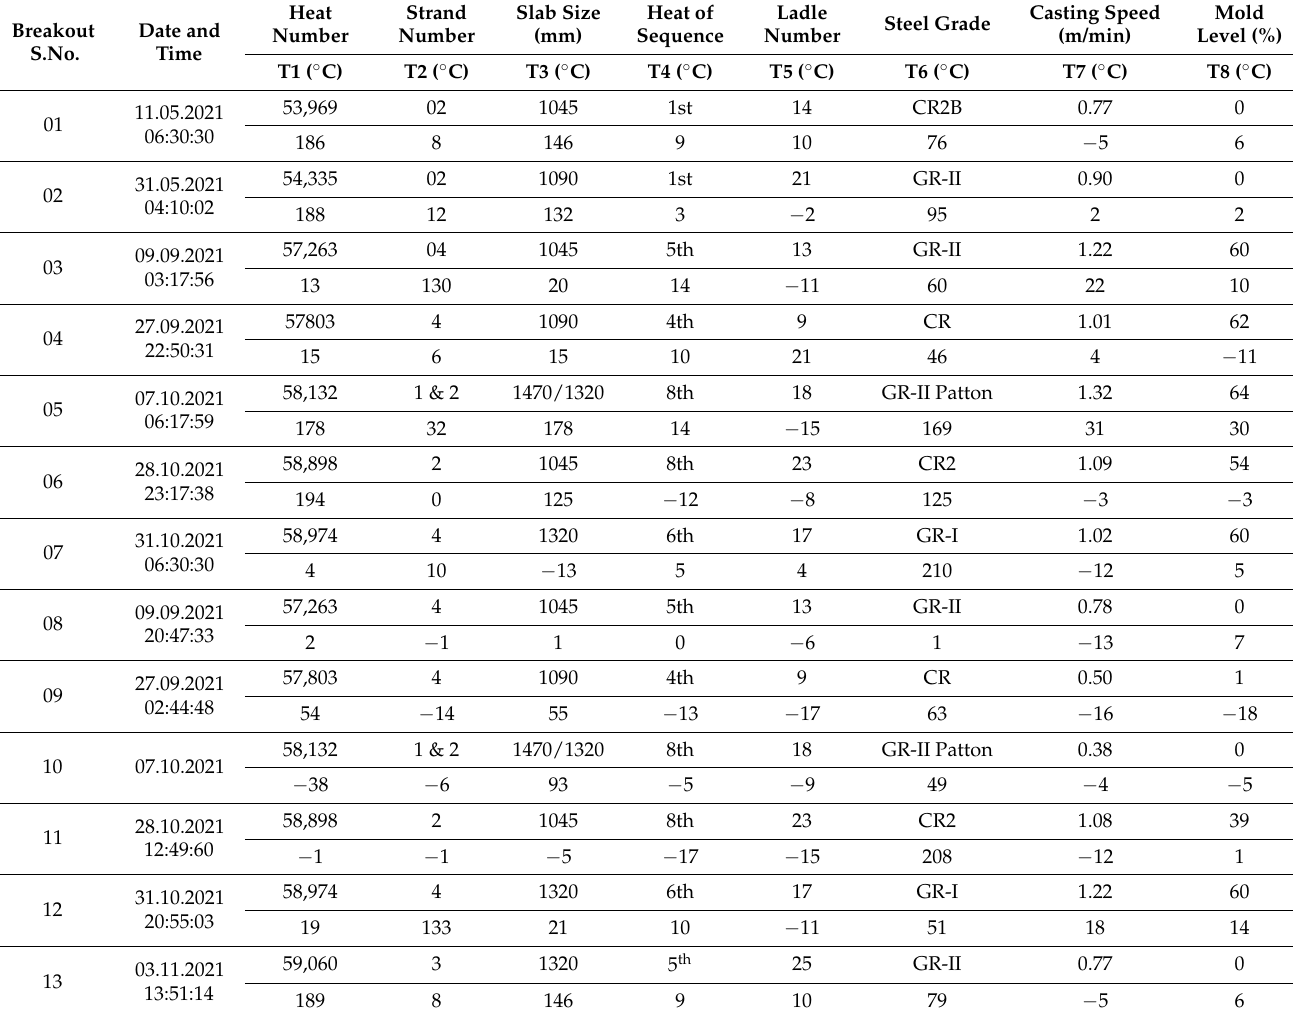
Table 9. Breakout in continuous casting shop (CCS) from 1 April 2021 to 31 September